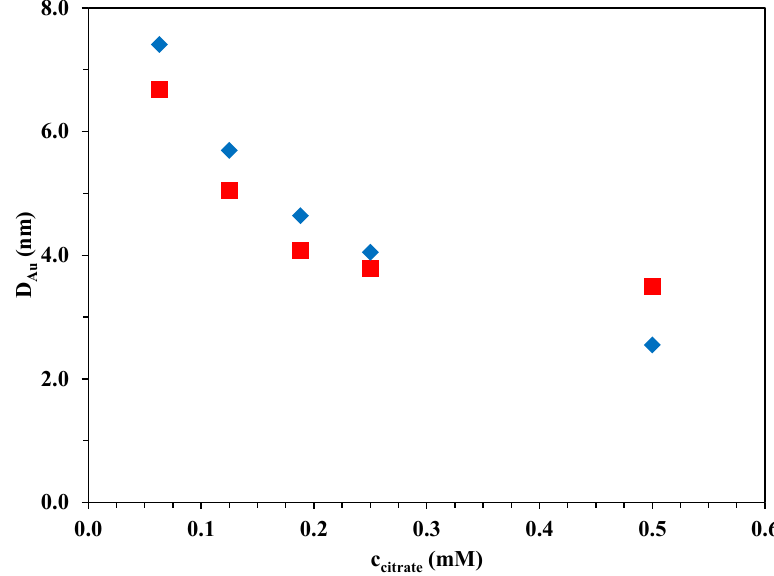
Figure 4. Dependence of the average Au nanoparticle size on the TC concentration during the synthesis (♦ Au-P25-CRIS, ■